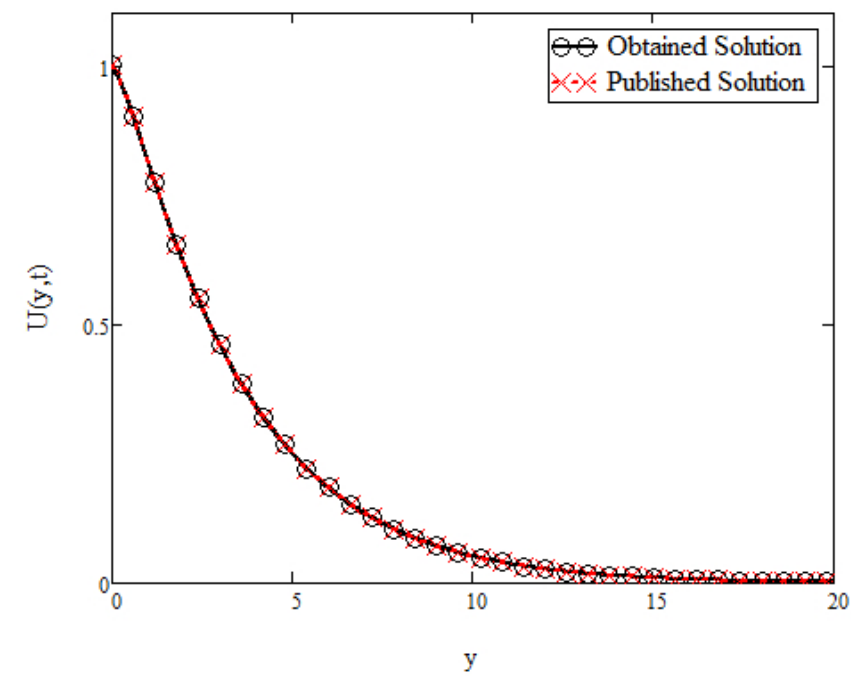
Figure 5. Comparison between published results from Ali et al. [35] and present results from Equation (20) on the velocity